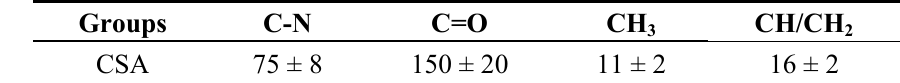
Table 1. Simulated CSA values of different carbon groups from Figure 4. The unit of CSA values is in ppm. The errors were deduced in the SIMPSON